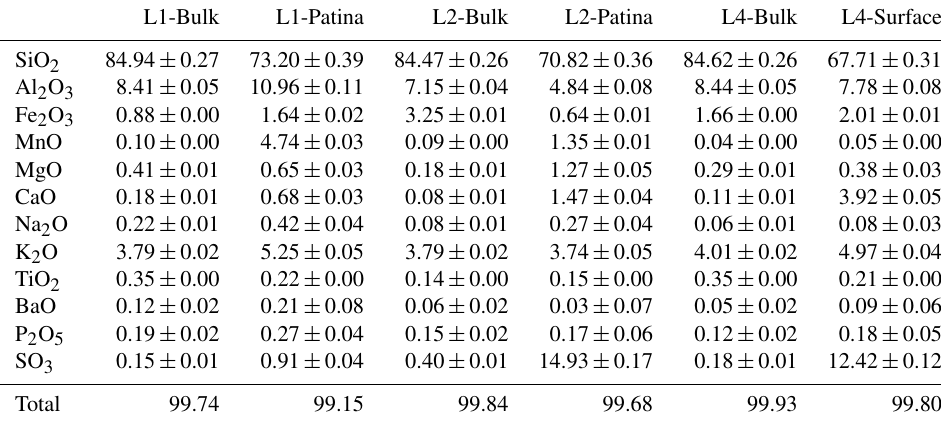
Table 1. Chemical composition (oxide wt%) of L1, L2, and L4 bulks and surfaces obtained by PIXE.